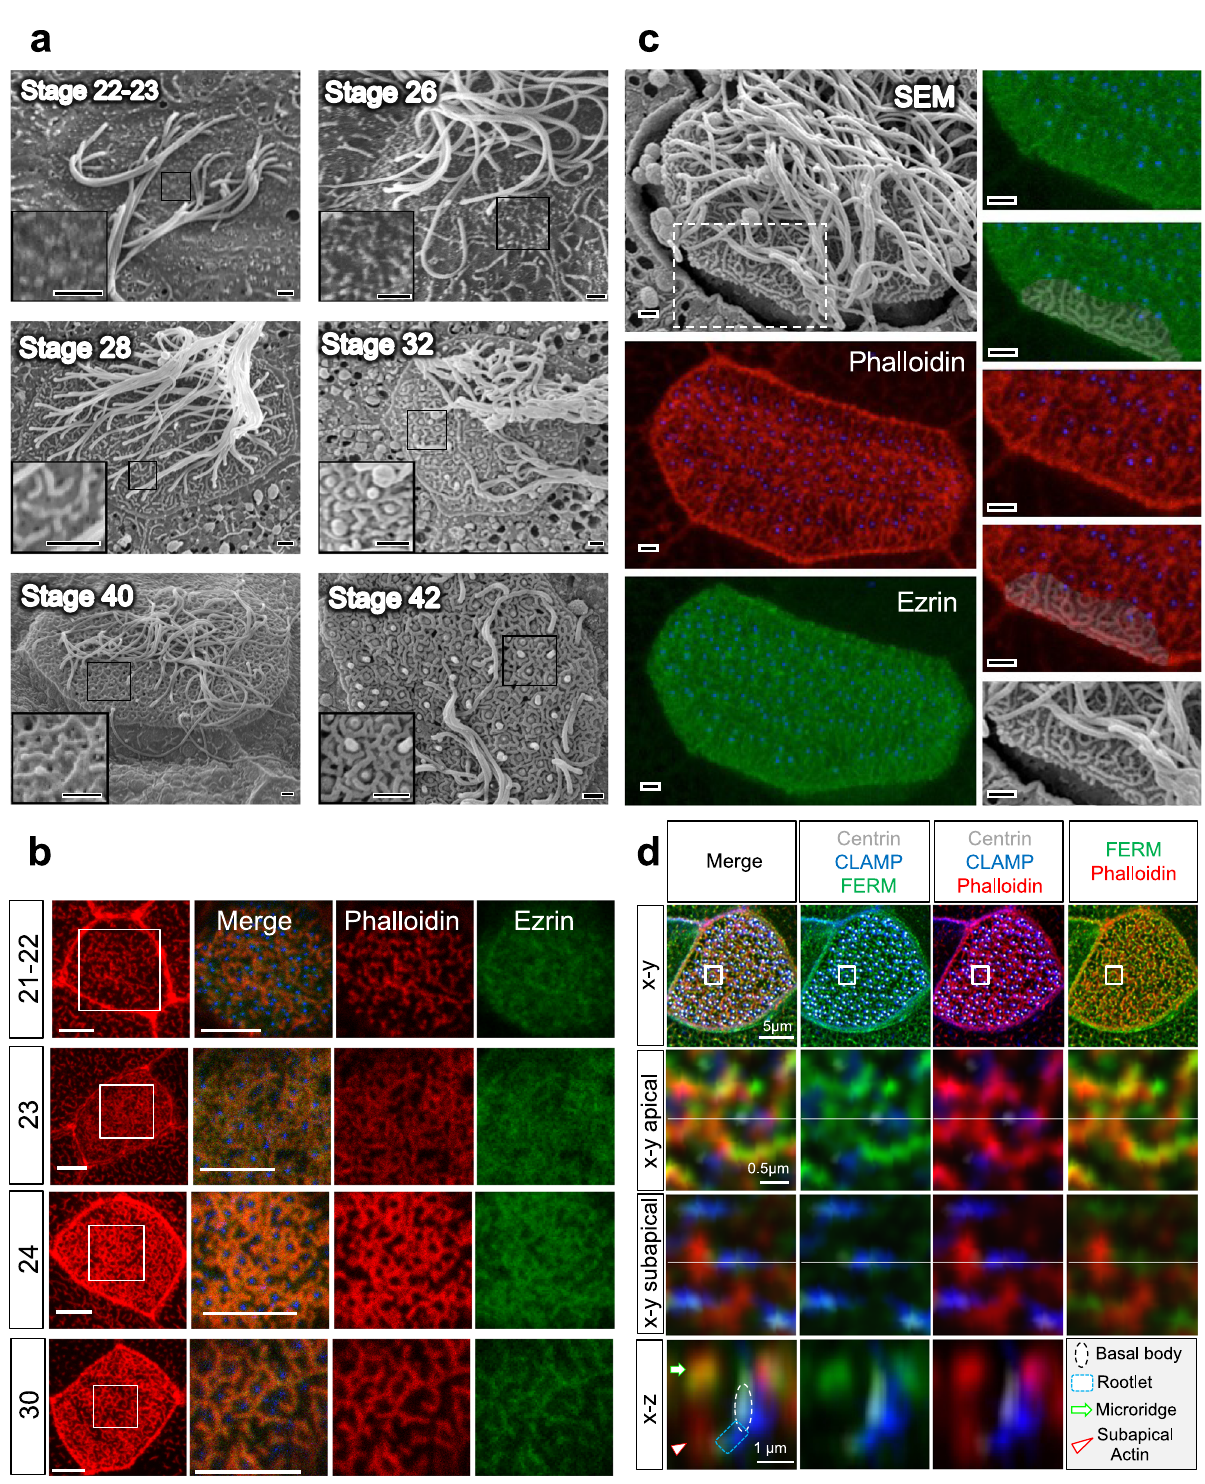
Fig. 5 Microridge formation coincides with actin and Ezrin organization. a Scanning electron microscopy (SEM) revealed that microridges form at stage 26, and continued to increase in complexity towards stage 40, when cilia start to retract (scale bars, 1 µ m). b Ezrin, labeled with GFP, follows the organization of actin bundles that surround the basal bodies, labeled by BFP-Centrin in the merged image (scale bars, 5 µ m). c Correlation between SEM and phalloidin (red)-label actin fi laments revealed that the actin bundles observed in the apical actin layer follow the microridges detected by SEM (scale bars, 1 µ m). d High-resolution confocal imaging reveals that actin bundles (phalloidin, red) arising from the anterior rootlet, connect to FERM-labeled microridges. Images were obtained at stage